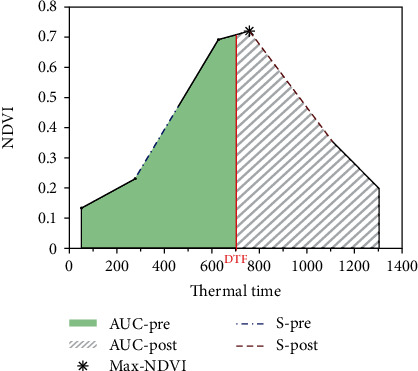
Canopy traits related to stay-green derived from the NDVI curve on an individual plot in Jimbour. Days to flowering for each plot were used as separator between the left and right sides of the curve. Integrals were estimated using the composite trapezoid rule. Traits, their corresponding abbreviation, relevance to stay-green parameters, and units are displayed in Table 1.